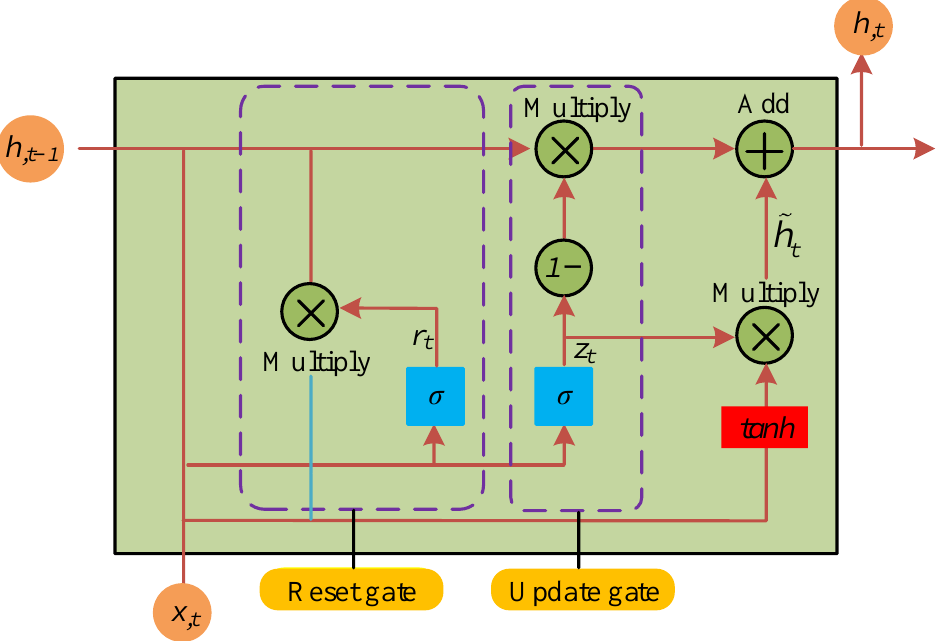
Figure 2. GRU gate control cycle unit structure. Figure 2 shows that the structure of the GRU consists of an update gate and a reset gate. In the update gate, the input at the moment determines the amount of information transferred between the upper and lower hidden layers through the sigmoid function, which reflects the GRU’s attention to historical data. In the gate, the activation function is used to determine the amount of information forgotten in the input at the moment, which reflects the update status of the information in the GRU network. Based on the gating unit and hidden layer, the analysis of information at each moment is realised, focusing on important information and ensuring the delivery of effective information. The short-term prediction process of the VMD-GRU algorithm is shown in Figure 3. Figure 3 shows thatVMD-GRU prediction first requires the application of VMD to decompose the signal to reduce the complexity of the time series, and the resulting IMF is fed into the GRU network to make predictions after training parameters to achieve the monitoring of the health of civil and structural